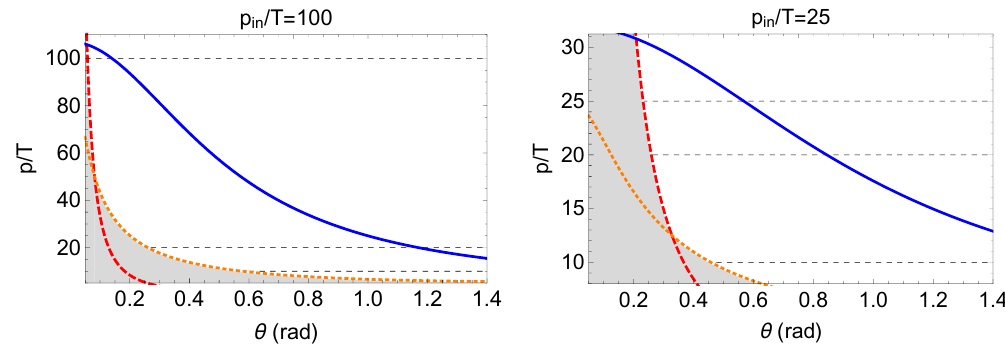
Figure 5 . The red and orange curves illustrate the boundary of the region in the ( (cid:18); p=T ) plane, analogous to what is often called the Lund plane, de(cid:12)ned by the conditions (3.5) where medium e(cid:11)ects can be neglected in the matrix elements for 2 $ 2 scattering processes, as we do in our calculations. The red dashed curve and the orange dotted correspond to (cid:0) ~ t = 10 m 2 10 m 2 , respectively. Our calculations are valid in the region above both these curves, and should D not be relied upon quantitatively in the shaded region. In plotting the curves in the left panel (right panel) we have chosen an incident parton with p in =T = 100 ( p in =T = 25). The horizontal black dashed lines in both panels show the location of p = p in , p = 20 T and p = 10 T , the latter two corresponding to the two di(cid:11)erent choices of p min that we employed in our evaluation of P ( (cid:18) ) in (cid:12)gure 4. The solid blue curves in both panels are determined by the condition k min = 7 T where k min is the minimum possible value of the energy of a parton in the medium that, when struck by a parton with incident energy p in , can yield an outgoing parton at a given point in the ( (cid:18); p=T ) plane. k min is given by the expression (2.29), and we have used p in =T = 100 (left panel) or p in =T = 25 (right panel) in our numerical evaluation of k min . All our results become smaller and smaller farther and farther above the blue curves. Hence, our calculations are valid and our results are not small in the region below the blue curves and above the red and orange